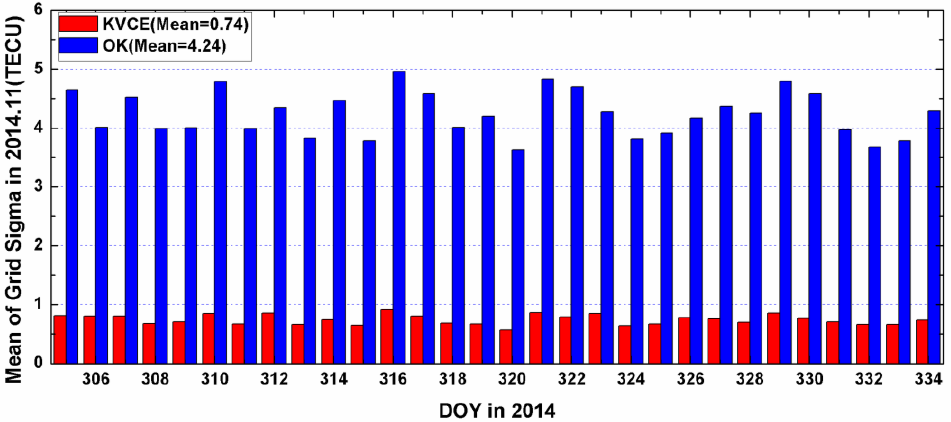
Figure 11. The daily mean grid sigma of KVCE and OK in 2014.11.